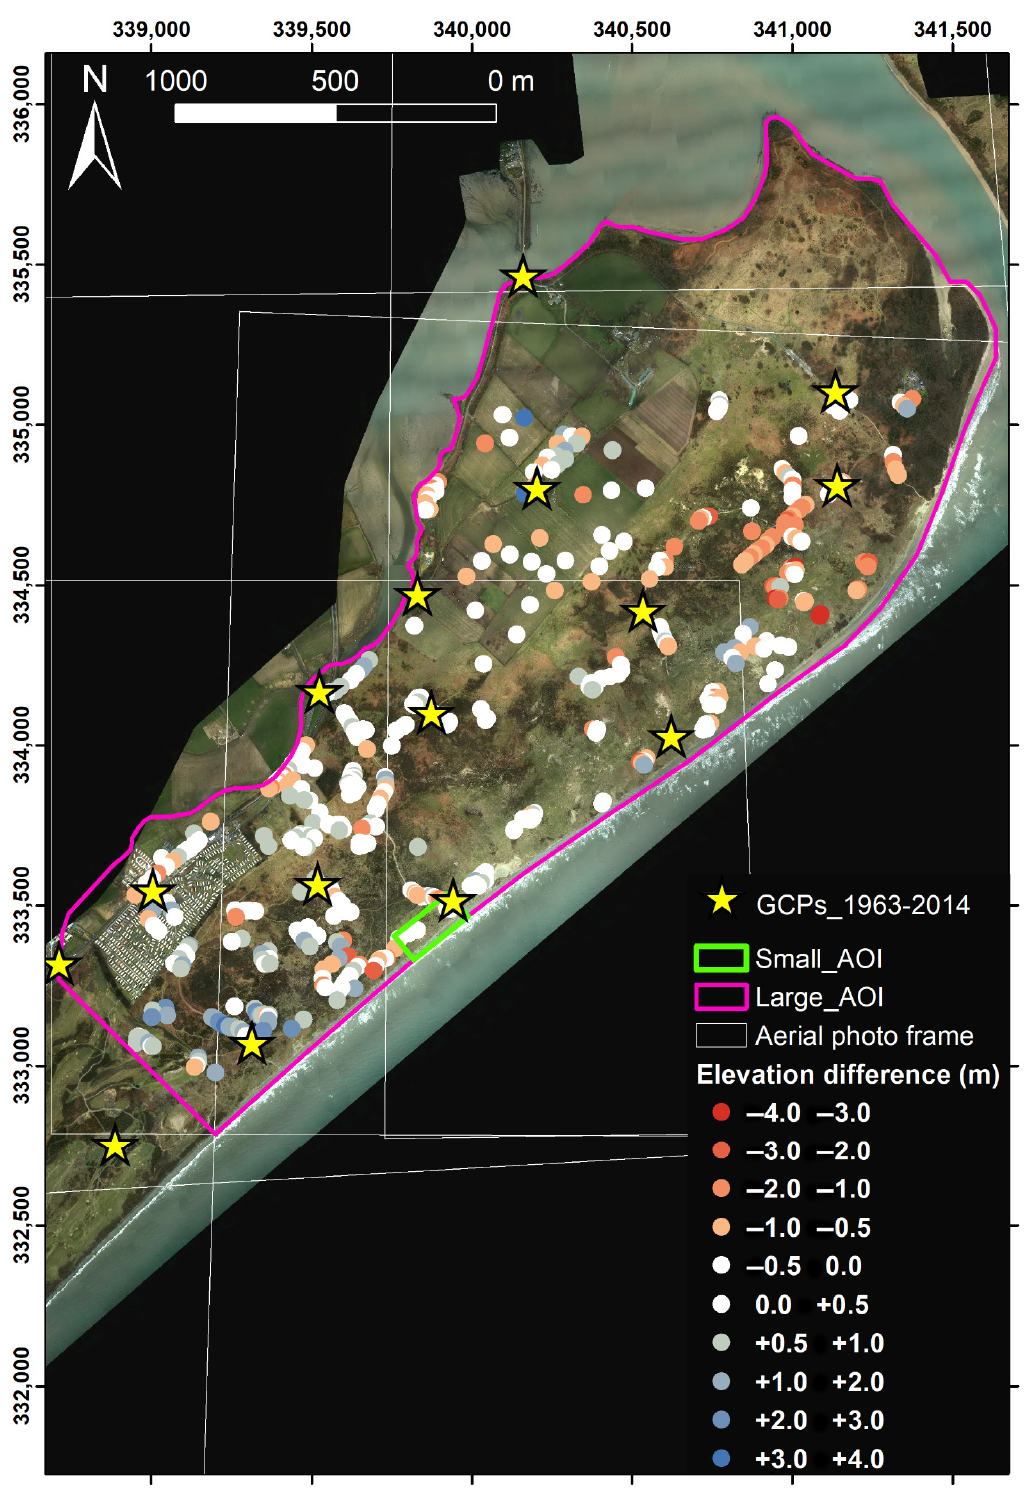
Figure 6. Elevation difference between the digital surface model (DSM) derived from the light detection and ranging (LiDAR) survey from 2014 and the aerial photograph (AP) derived from the DSM from 1963 using the best structure-from- motion method resulting from the accuracy assessment. Cold colors (positive values) mean that the LiDAR-derived DSM is higher than the AP-derived DSM, and vice versa. The background 2014 orthophoto is derived from the LiDAR survey. The graticule is in TM75/Irish Grid (transverse mercator)